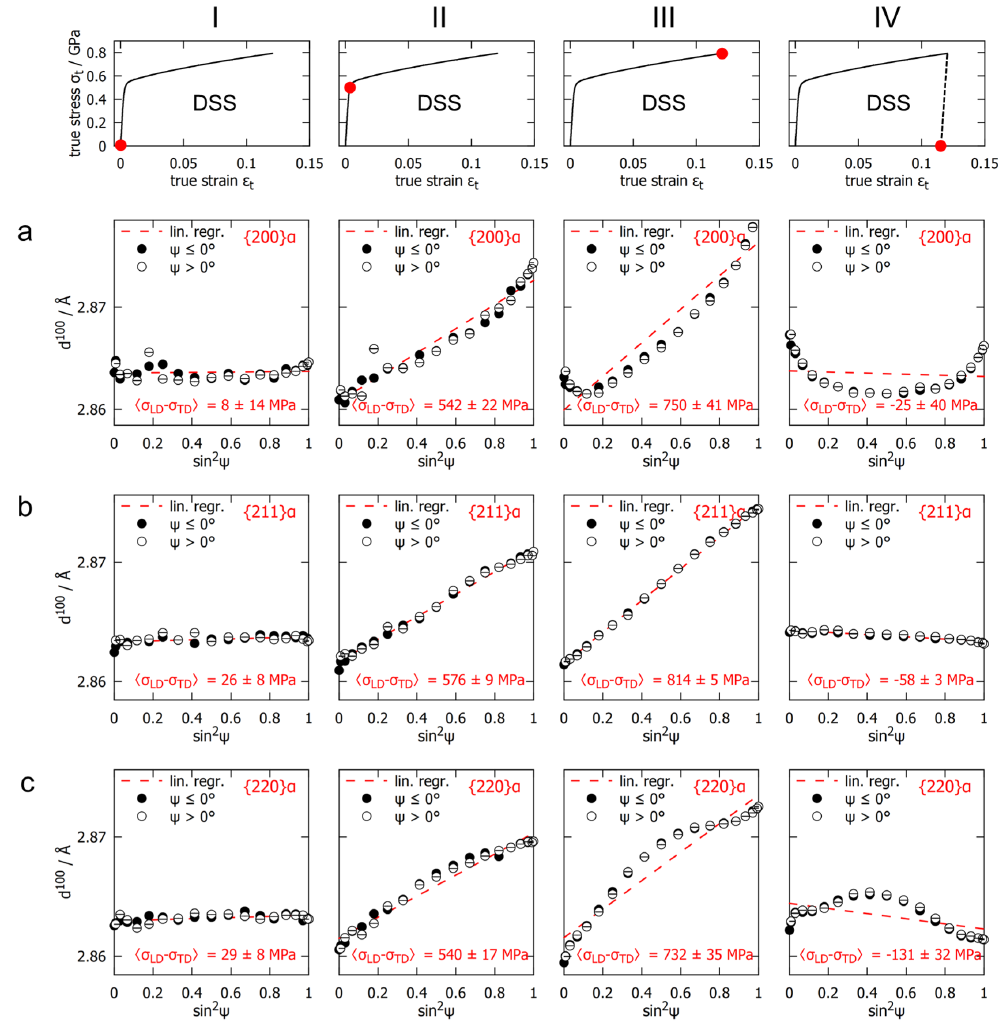
Figure 9. d 100 − sin 2 ψ distributions of ferrite lattice planes { 200 } α ( a ), { 211 } α ( b ) and { 220 } α ( c ) for selected load states during tensile deformation of the DSS: initial state ( I ), macroscopic yield strength ( II ), plastically deformed ( III ) and unloaded after deformation ( IV ); stress differences (cid:104) σ LD − σ TD (cid:105) α determined by linear regression (red dotted line) according to the sin 2 ψ